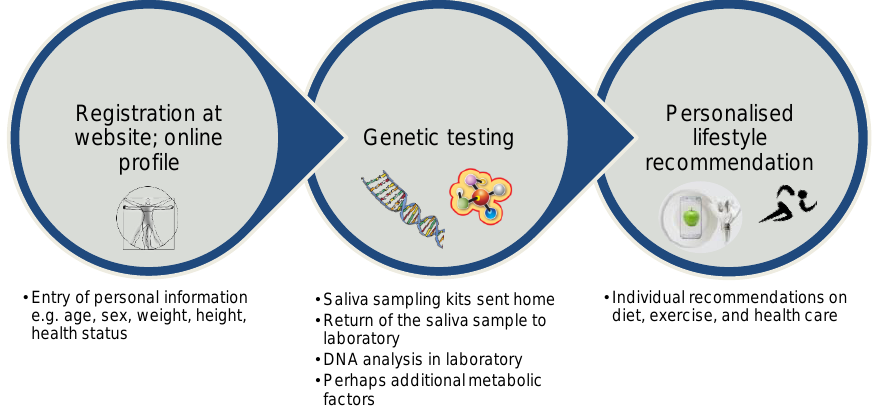
Figure 2. Schematic workflow of a commercially available gene-based dietary recommendation. DNA, deoxyribonucleic acid.